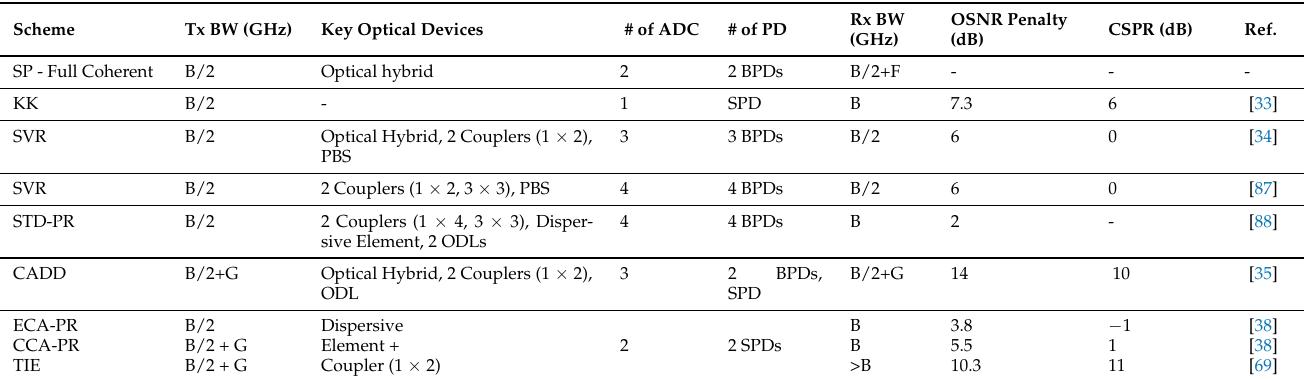
Table 2. A comparison of different phase retrieval schemes: KK, ECA-PR, CCA-PR and TIE